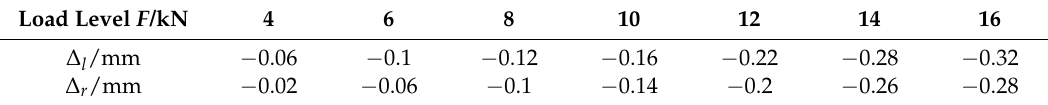
Table 3. Settlement values at beam ends of timber frame model under different load levels.